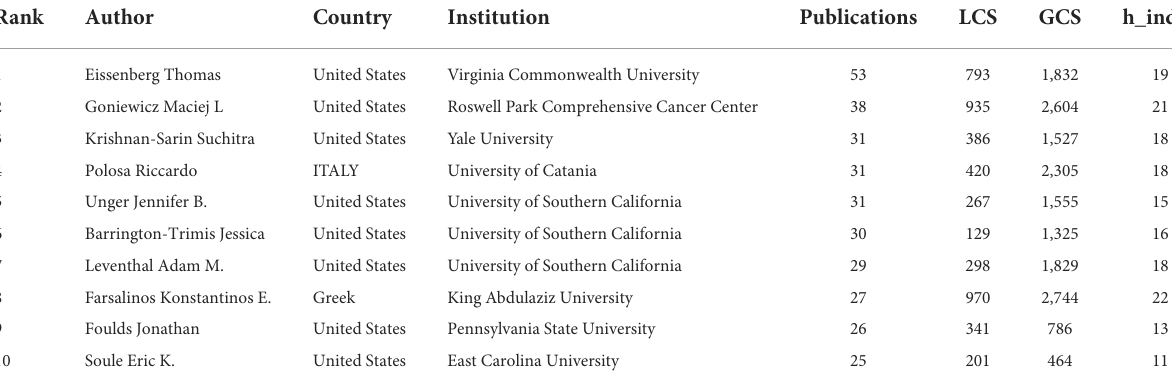
TABLE 3 The 10 most prolific authors in the field of e-cigarette research.